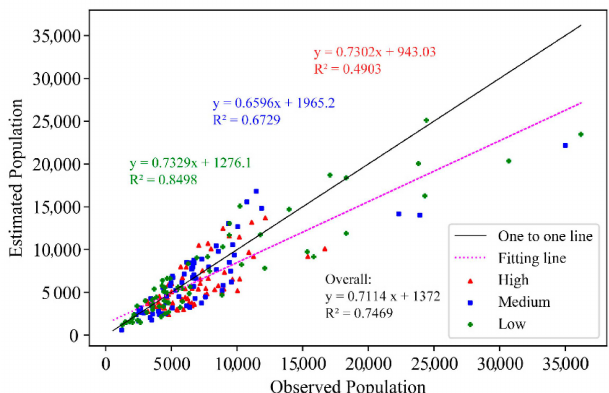
Figure 7. Scatterplot of the predicted and census populations of the communities.